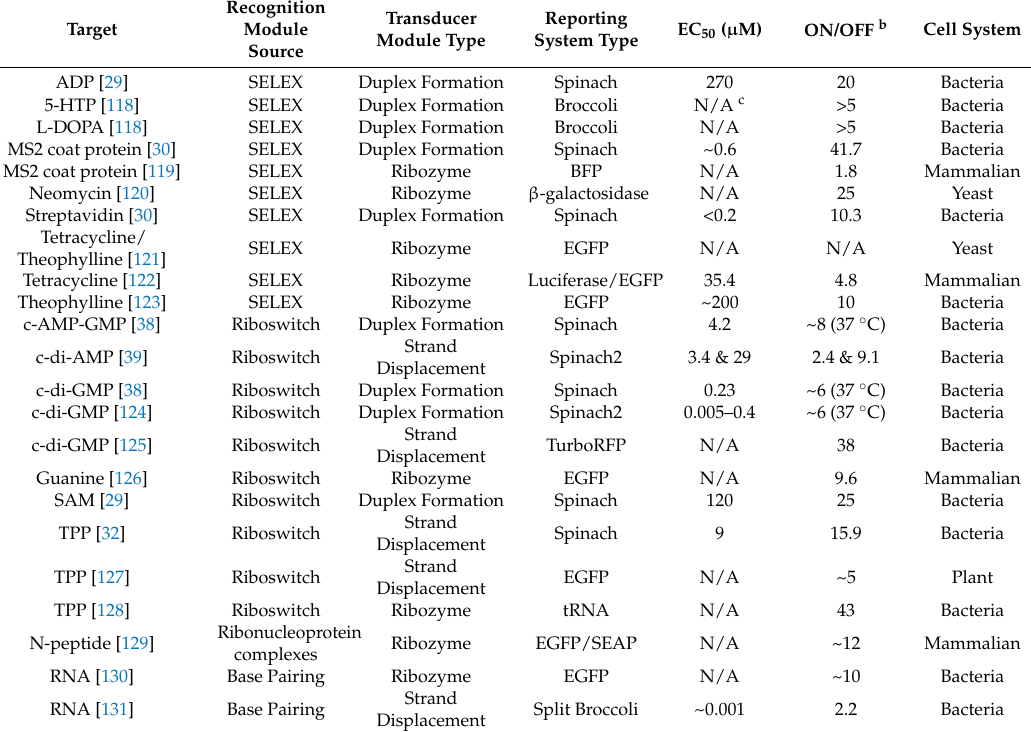
Table 2. Properties and design of existing GERMS for intracellular applications.